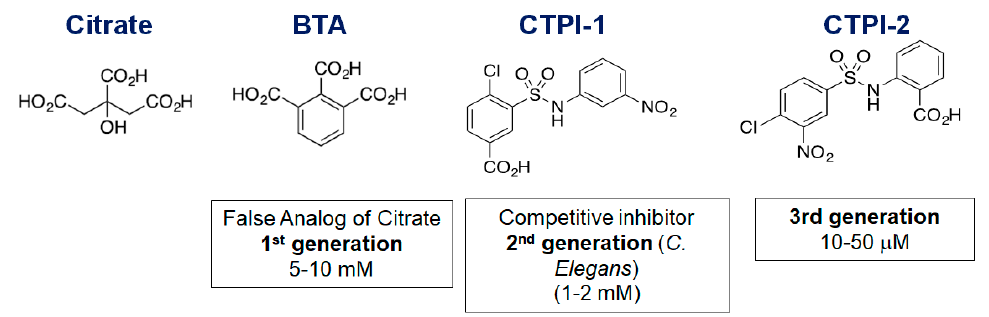
Figure 2. Comparison of the structure of CIC inhibitors. The in vivo IC50 is indicated for each of the compounds.